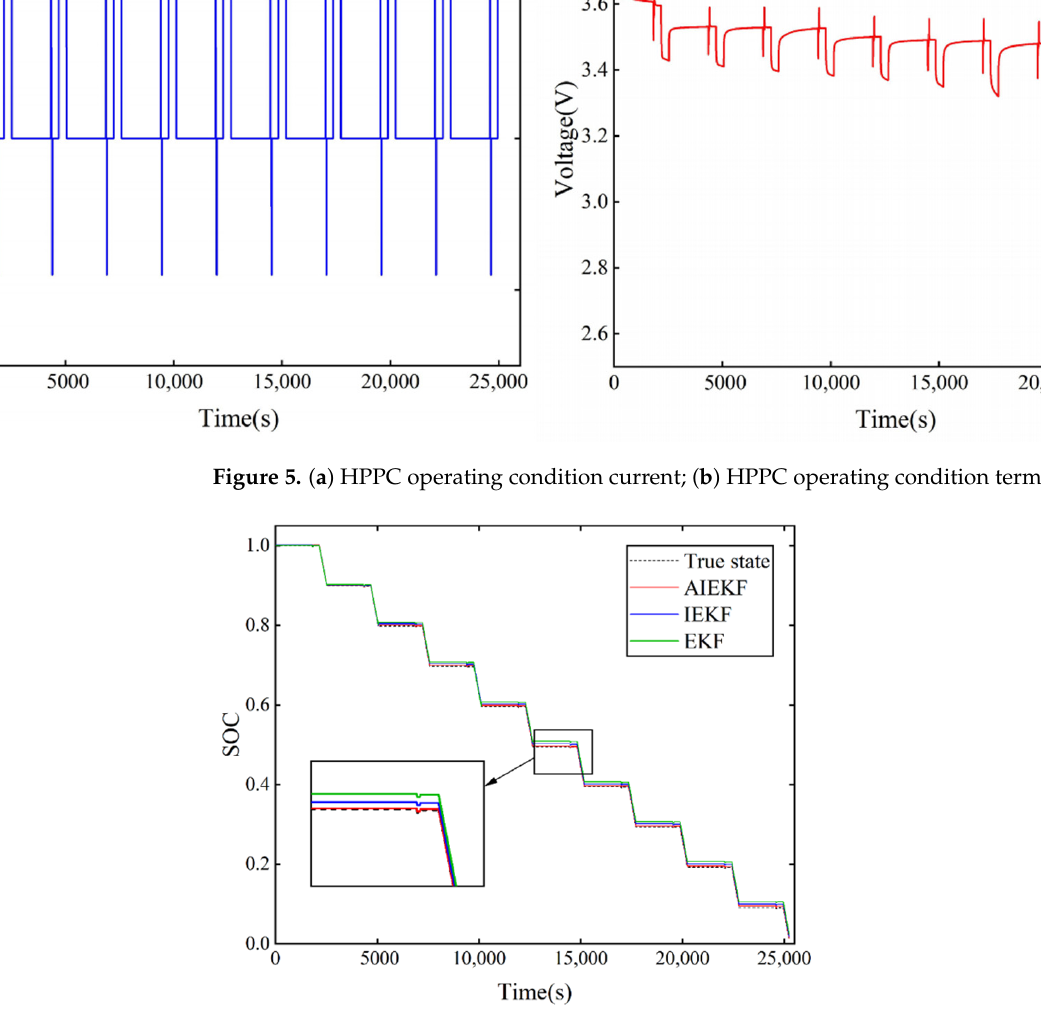
Figure 5. ( a ) HPPC operating condition current; ( b ) HPPC operating condition terminal voltage .